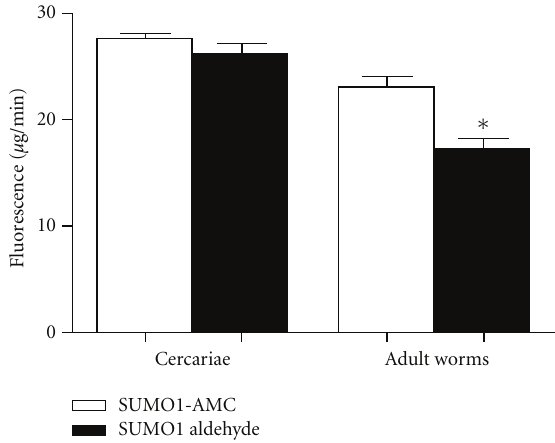
Figure 4: Sm SENP1 enzymatic activity in S. mansoni . The fluores- cence levels were measured based on three replicates, in cercariae and adult worm stages. Statistical analysis was performed using t tests followed by unpaired test P < 0.05. ∗ Di ff erent from